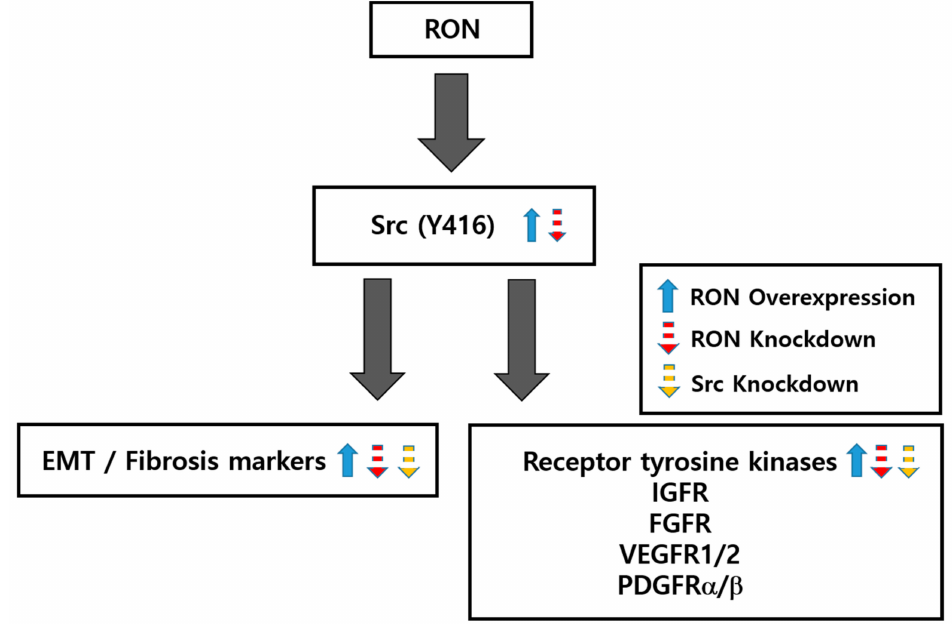
Figure 8. Schematic diagram of the regulation of EMT, fibrosis, and RTKs by RON and Src. Src phosphorylation, EMT, and fibrosis are regulated by RON overexpression and siRNA knockdown in HK-2 and NRK49F